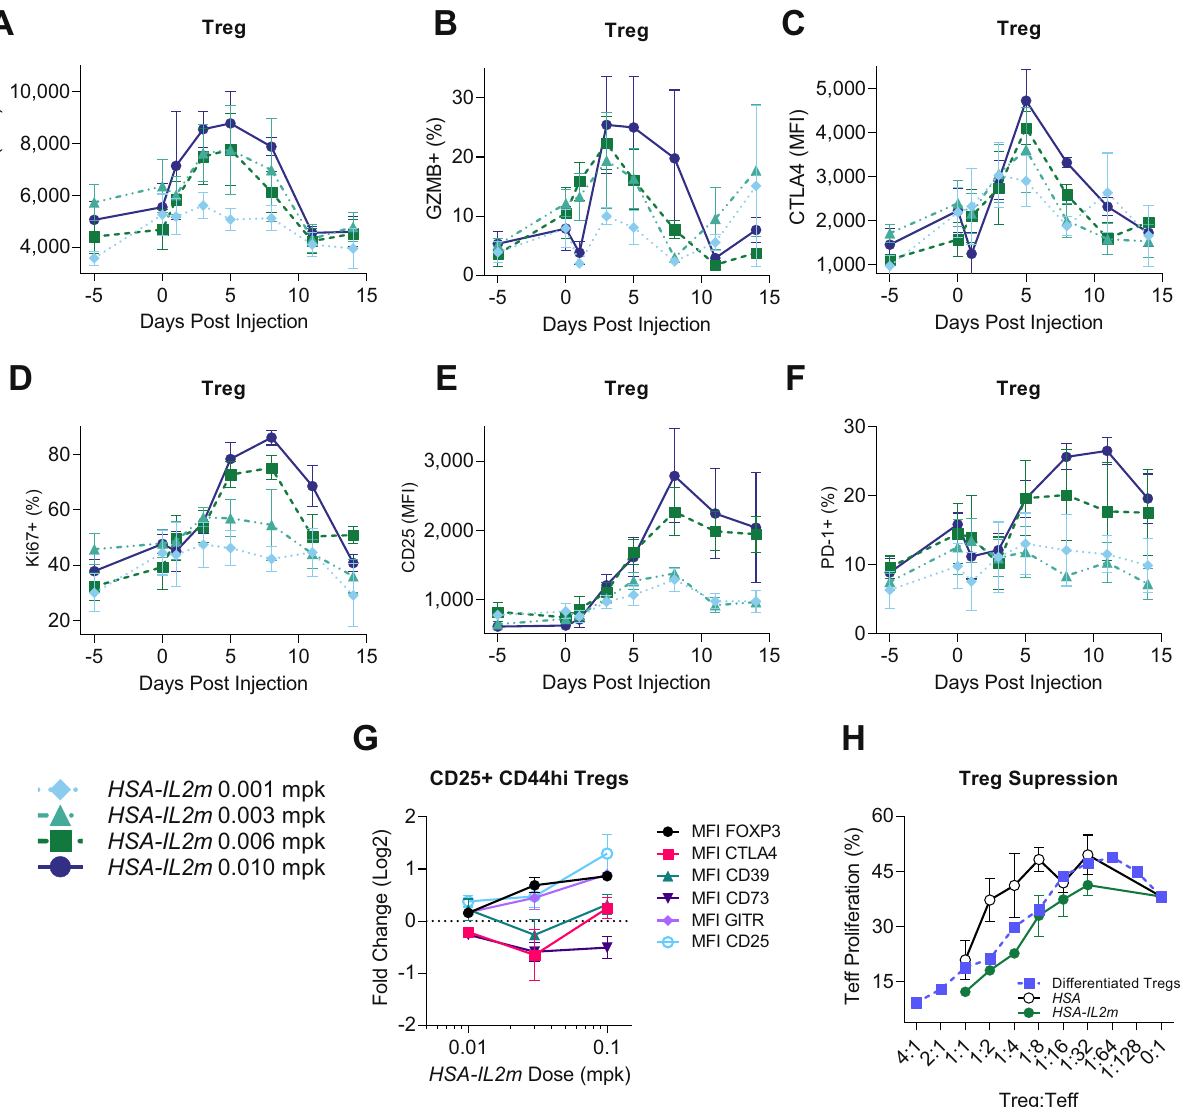
Fig. 3 Characterization of regulatory T cells in mouse and cynomolgus monkey following HSA-IL2m treatment. A FOXP3 MFI, B frequency of GZMB + , C MFI of CTLA-4, D Frequency of Ki67 + , E CD25 MFI, F frequency of PD-1 + in cynomolgus monkey Tregs following HSA-IL2m treatment ( n = 4). G median fl uorescence intensity of FOXP3, CTLA4, CD39, CD73 and GITR in murine Treg following HSA-IL2m treatment in C57BL/6 mice ( n = 6). H Suppression of conventional T cells by regulatory T cells from control mice ( HSA ), HSA-IL2m , and in vitro differentiated Tregs ( n = 3). Data are presented as mean ± s.e. ( A – F ) and mean ± s.d. G – H Source data are provided as a Source Data fi